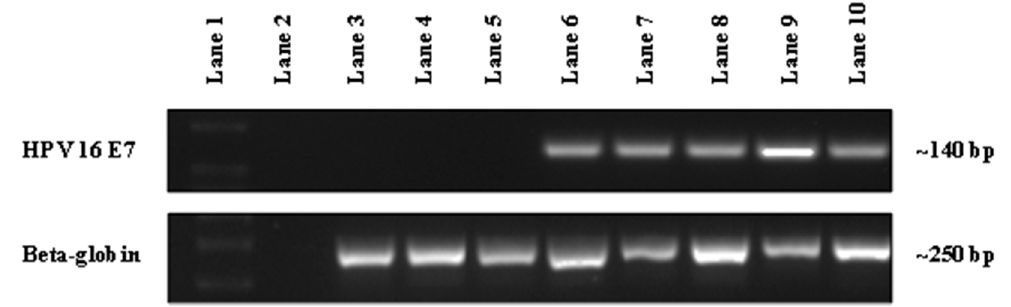
Figure 1. The detection of human papillomavirus (HPV)-16 DNA in patient oral rinse samples from UQ Dental School Clinic by PCR. Representative gel image showing the detection of HPV-16 DNA in patient oral rinse samples using HPV-16 NB2 primers (~140 bp) with beta-globin used as an internal control (~250 bp). Lane 1 represents DNA Ladder; Lane 2 represents non-template control; Lanes 3–5 (134, 144 and 145) represent the absence of HPV-16 DNA in patient samples; Lanes 6–8 (236, 1338 and 1368) represent the presence of HPV-16 DNA in patient samples and Lane 9 (93VU147T) and 10 (Caski) represent HPV-16 positive cancer cell lines.